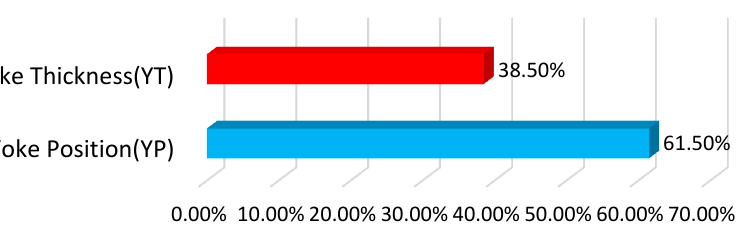
Figure 25. Analysis results of sensitivity for performance factor of magnetic thickness minimization by 3 sigma level.